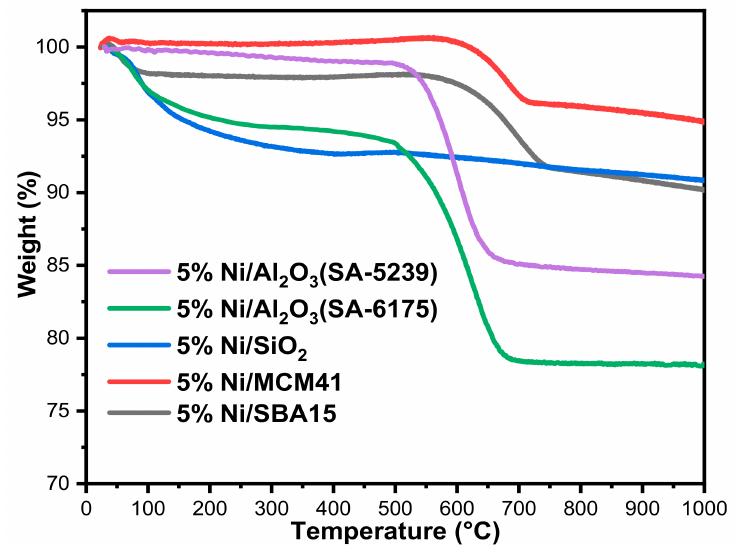
Figure 7. Curves showing the quantitative analysis of the deposited carbon on the used